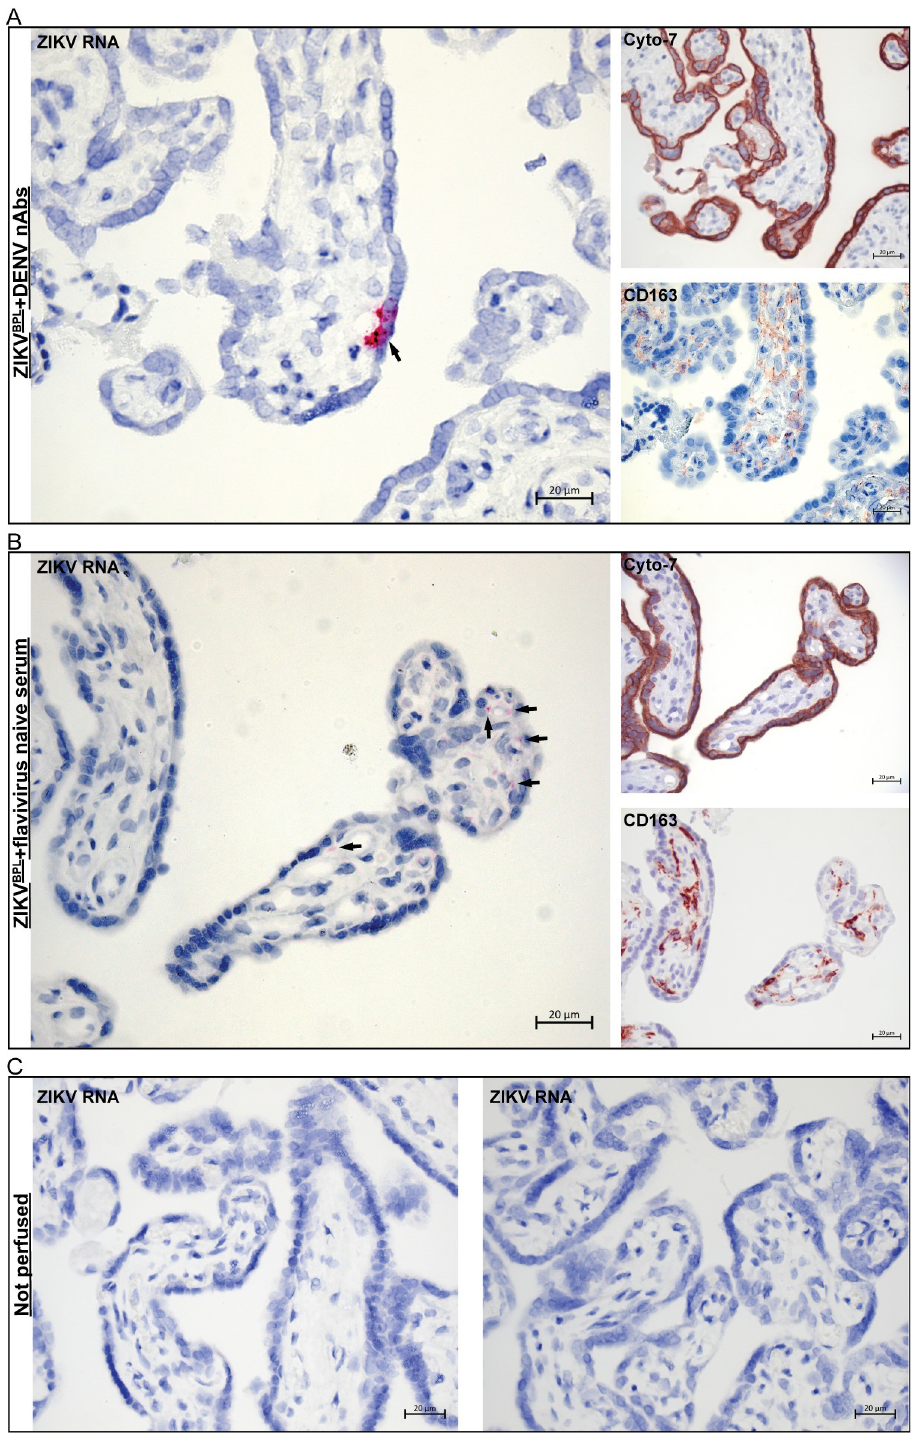
Fig 2. Detection of ZIKV RNA in chorionic villi of placentas perfused with ZIKV. ZIKV RNA was detected with ISH in formalin fixed, paraffin embedded tissue of perfused placentas. Chromogenic staining for cytokeratin-7 (cyto- 7) and CD163 was performed in sequential slides to detect trophoblasts and Hofbauer cells, respectively. A: Staining for ZIKV RNA, trophoblasts and Hofbauer cells in a placenta that was perfused for 40 minutes with ZIKV BPL +DENV nAbs. B: Staining for ZIKV RNA, trophoblasts and Hofbauer cells in a placenta that was perfused for 120 minutes with ZIKV BPL +flavivirus na ï ve serum. C: Staining for ZIKV RNA in a placenta that was obtained directly after birth and was not perfused. Arrows indicate positive signal for ZIKV